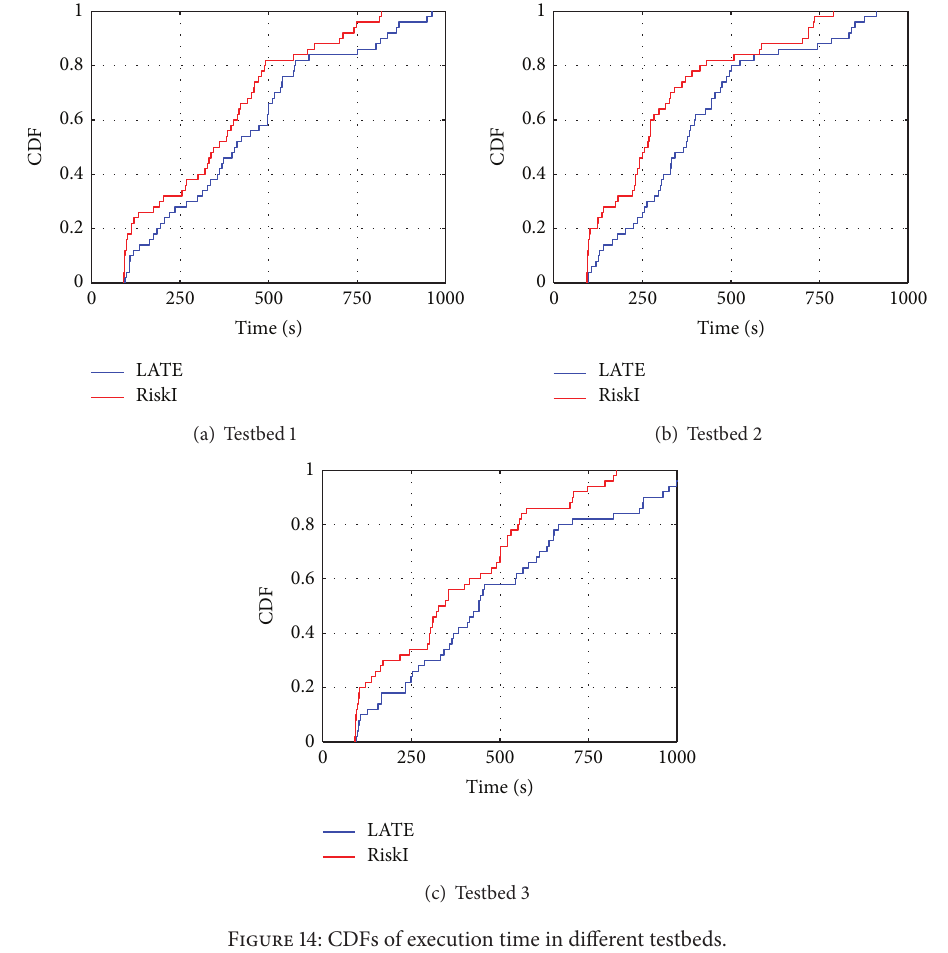
Figure 14: CDFs of execution time in different testbeds.